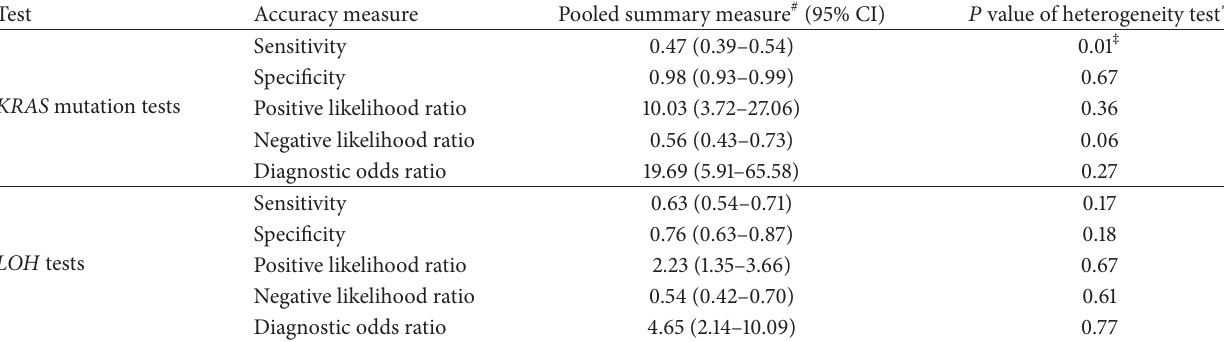
Table 3: Accuracy measures of molecular diagnostic analyses for the differentiation of mucinous from nonmucinous pancreatic cysts.